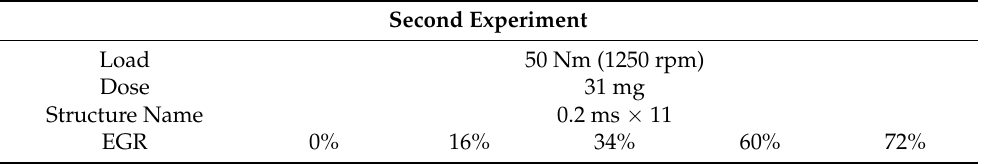
Table 3. Cases of the second